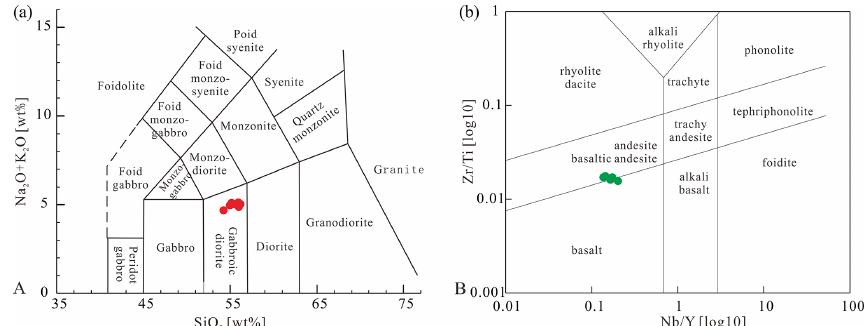
Figure 4. Classification of rocks of the GA1 well with a TAS diagram and revised Winchester–Floyd diagram: (a) samples from fresh and sufficiently fresh parts of the basement; (b) samples from overlain